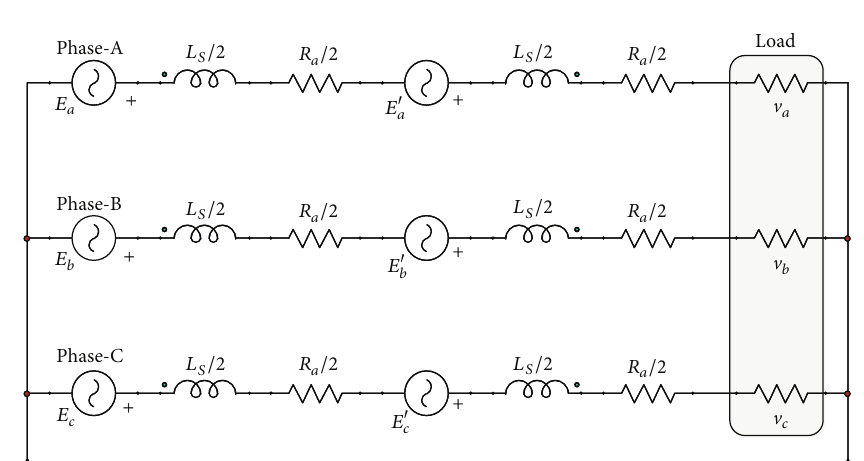
Figure 4: Vector diagram.